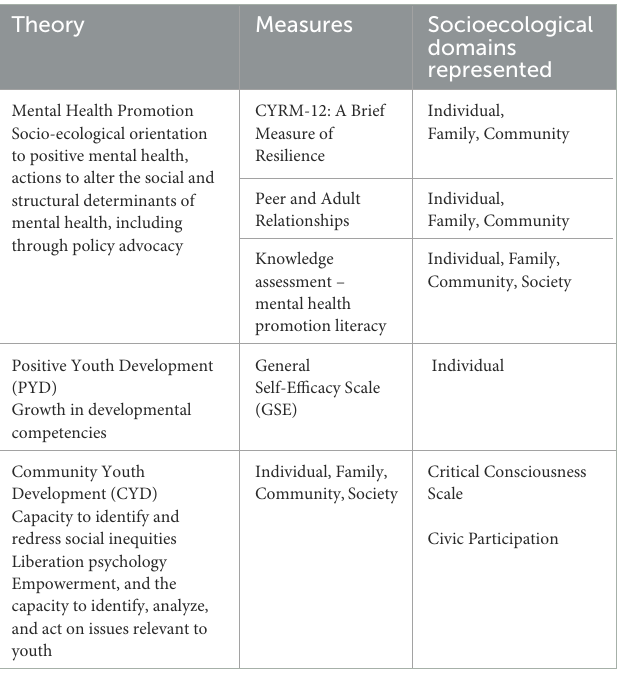
TABLE 1 Intervention theories mapped to corresponding socioecological domains and